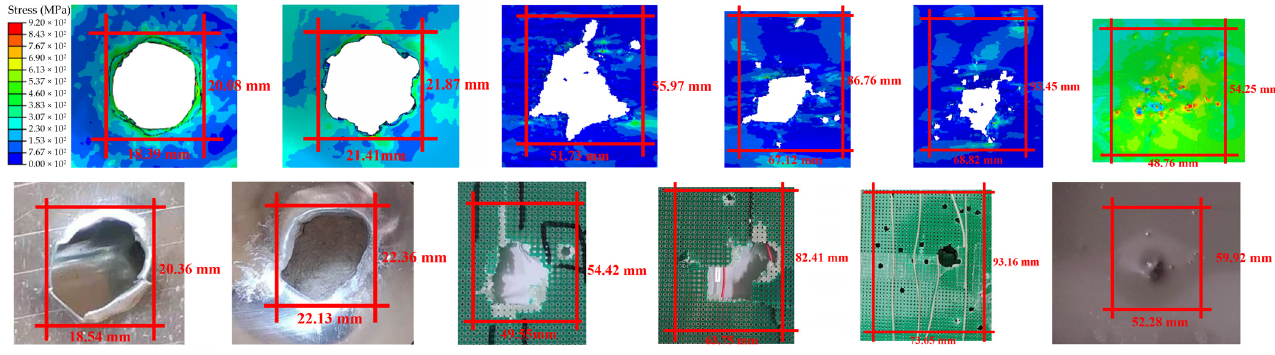
Figure 6. The comparison of damaged targets between the simulation and test.